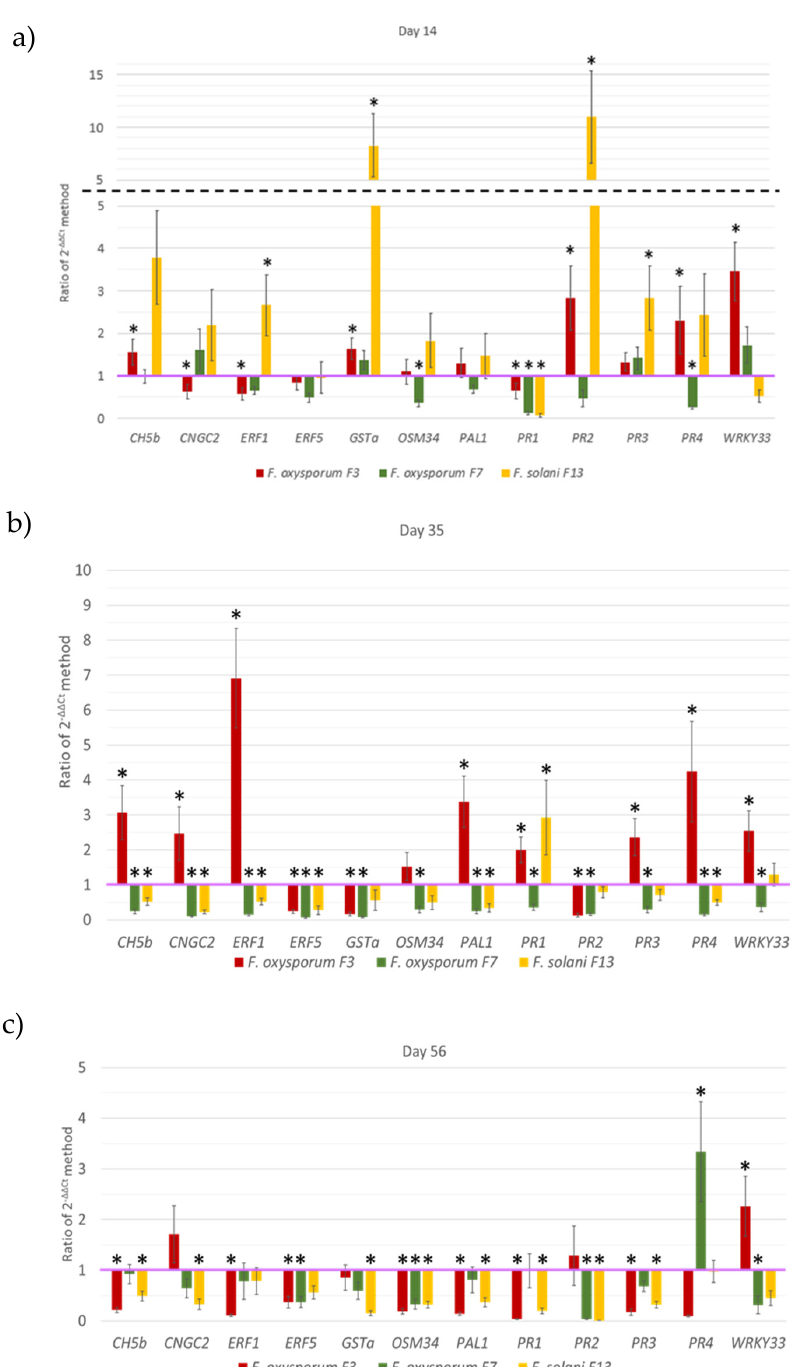
Figure 4. Analysis of relative expression levels of the bean defense-related genes in ( a ) 14, ( b ) 35, and ( c ) 56-day-old bean plants treated with pathogenic F. oxysporum F3 (red), low-pathogenic F. oxysporum F7 (green), and low-pathogenic F. solani F13 (yellow) compared to control plants. The purple line represents the expression level of each gene in control plants. Values are 2 − ∆∆ Ct ± SD (standard deviation bar) of 3 measurements. The data were analyzed by the 2 − ∆∆ Ct method. An asterisk (*) indicates statistically significant di ff erences ( p < 0.05) between the gene expression of treated and control